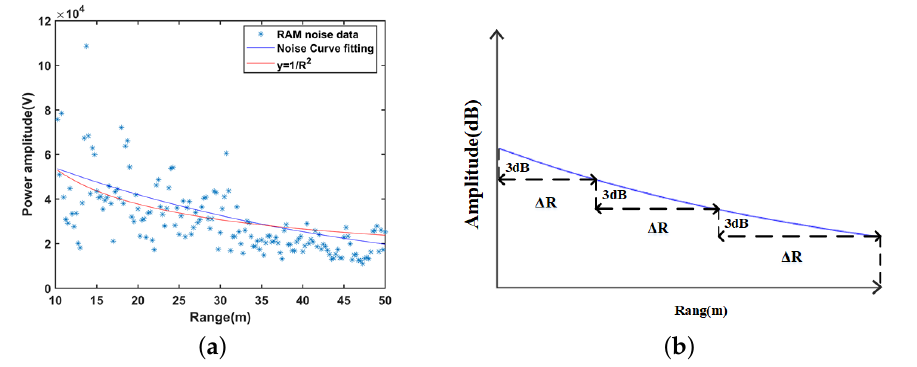
Figure 12. RAM noise analysis and interval division. ( a ) Relationship between noise amplitude and distance in RAM. ( b ) RAM interval division for MC-CFAR